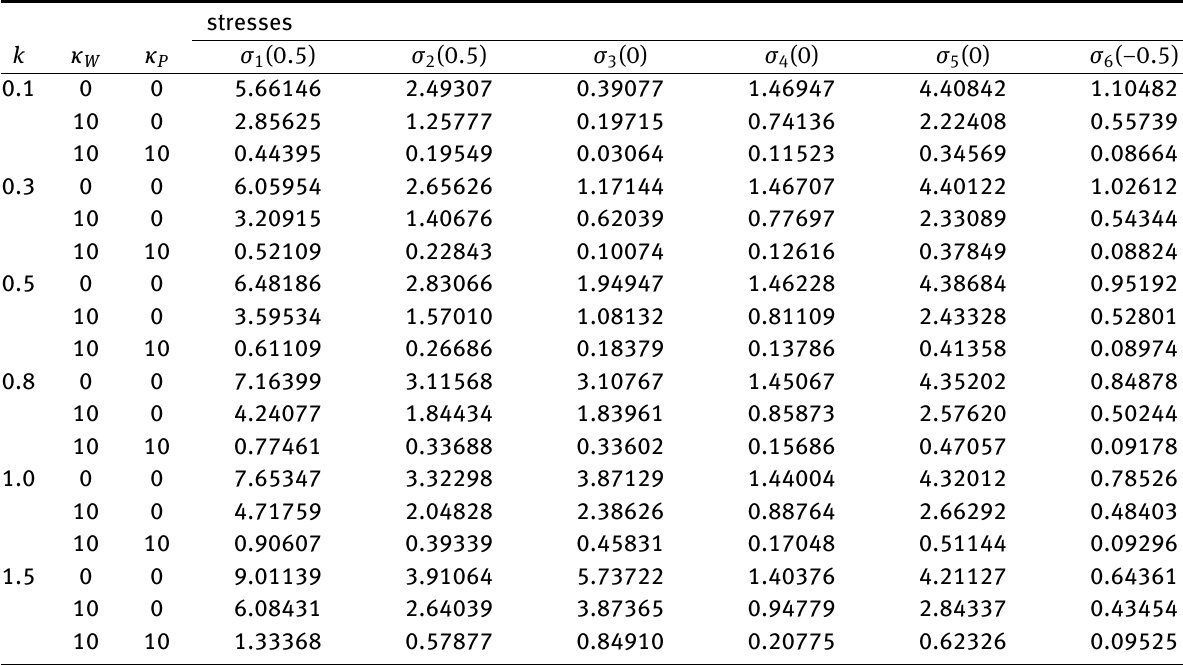
Table 5: Effect of the inhomogeneity parameter k on the stresses of the EG thick rectangular plate resting on elastic foundations by TPT ( a = 4 h , b = 3 a ) .